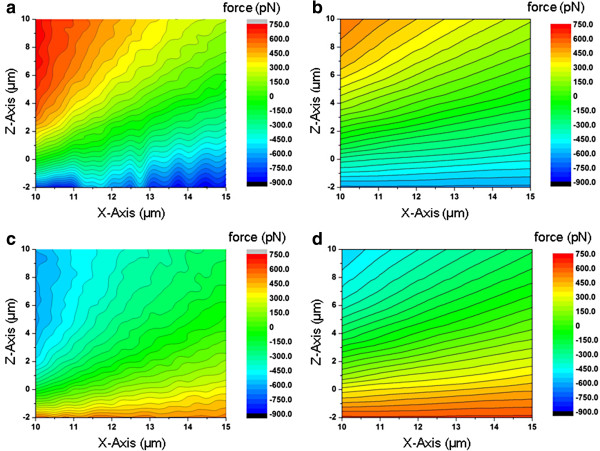
Experimental results vs. Ansoft Maxwell simulation. (a, c) The Fele(+25 V) and Fele(−25 V) distribution along the X-axis (0.25-μm spacing from 10 to 15 μm) and the Z-axis. (b, d) The results of Ansoft Maxwell simulation of electrostatic field distribution under Vapp = +25 and −25 V, respectively.